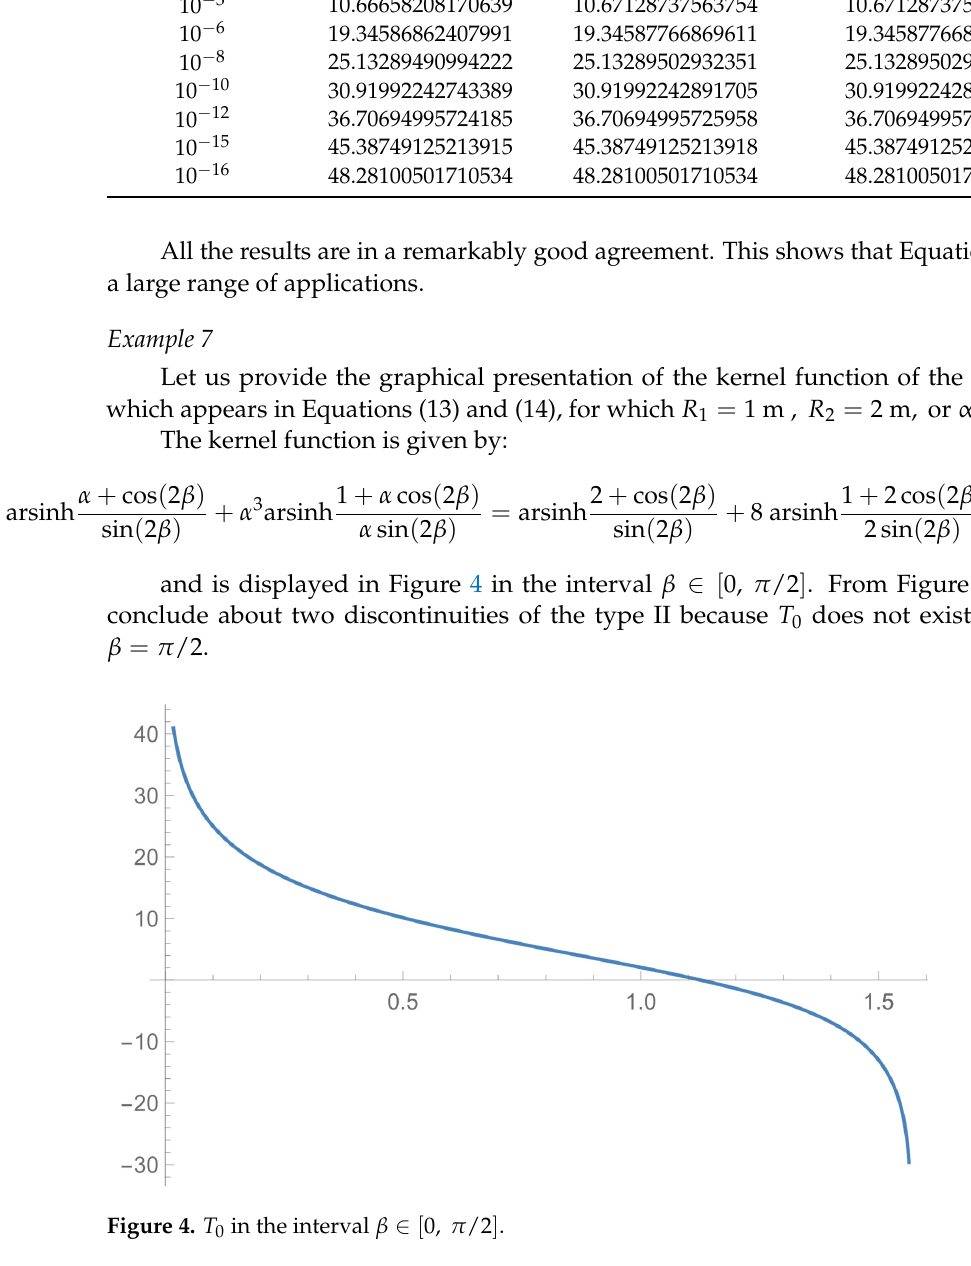
Table 4. Comparison of the results of Equation (14) with those from [12] (Equaition (58) and the asymptotic formula (20) there) as the singularity at the unit shape factor is approached. The results are given in μ H/m. (cid:2235) − (cid:2778)